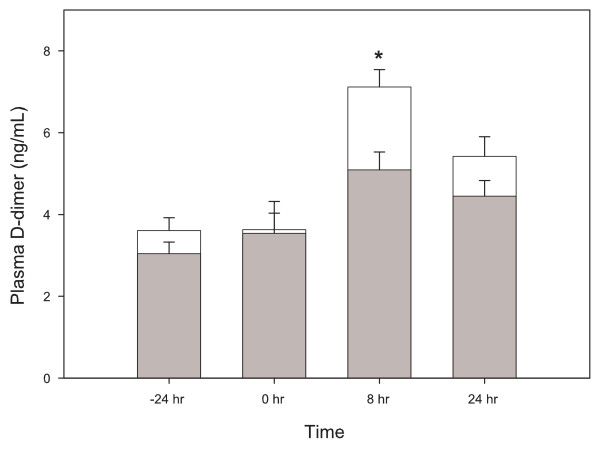
Plasma D-dimer concentration measured before (-24 hr), and 8 hr and 24 hr after clot injection in Sprague-Dawley rats. Grey bars are the sham animals and clear bars are the PE animals. Values were pooled from the 24 hour and 5 day experiment. Values are mean ± standard error, n = 20. Star indicates a value significantly higher than the sham value at the same time point.